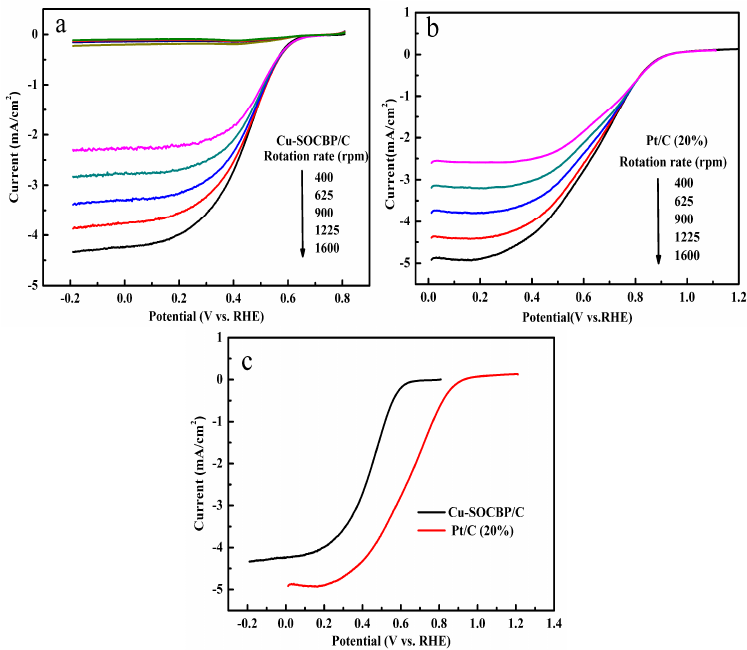
Figure 6. ( a ) Polarization curves of Cu ‐ SOCBP/C obtained at different rotating rates using N 2 ‐ saturated electrolyte (upper part) or O 2 ‐ saturated electrolyte (lower part). ( b ) Polarization curves of Pt/C with a dependence of current magnitude on rotation rate. ( c ) Polarization curves of Cu ‐ SOCBP/C and Pt/C at a rotating rate of 1600 rpm.